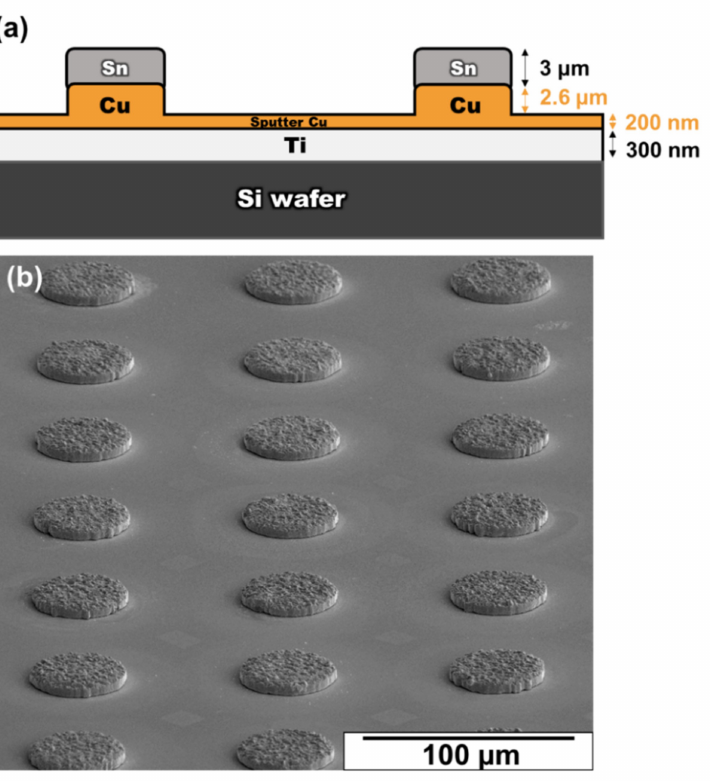
Figure 1. ( a ) Schematic drawing of the configuration of the Sn/Cu/Ti structure in this study; ( b ) Micrograph showing the top view of